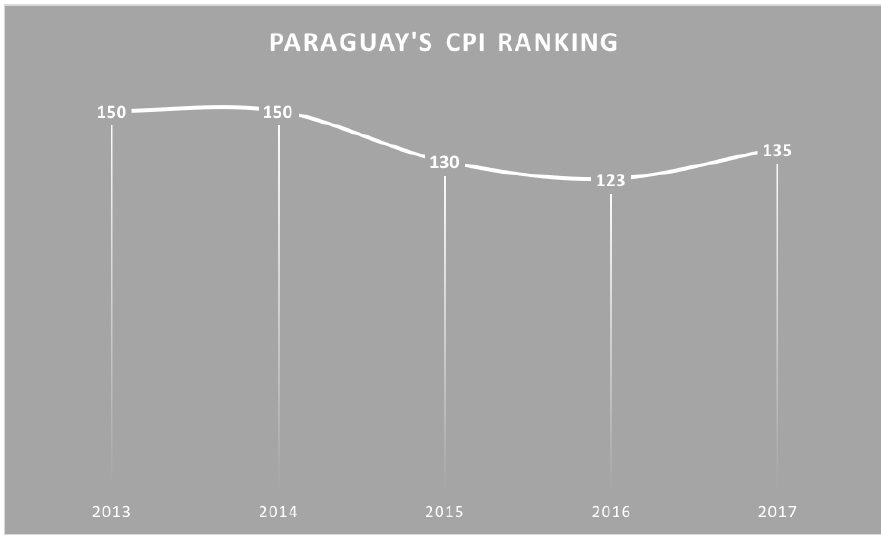
Figure 10: Paraguay’s CPI Ranking 2013 − 2017